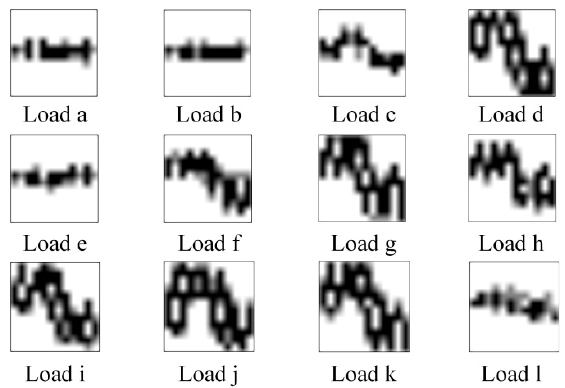
Figure 13. Feature image after the first convolution operation.